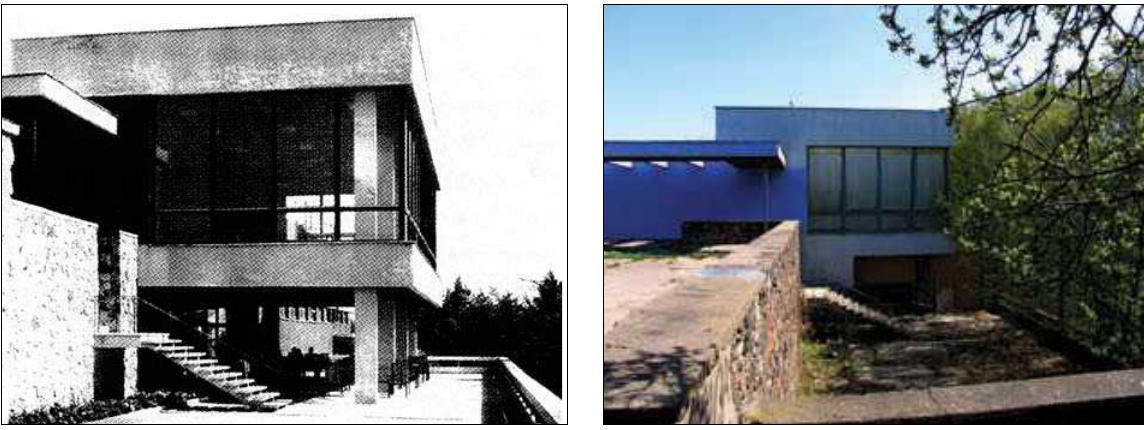
5, 6 pav. kavinė „trys mergelės“ kau­ne (arch. a­. and V. Jaku­čiūnai) 1967 m. ir dabar (5 pav. paimtas iš Lietuvos architektai/ LAS . Vilniu­s: Lietu­vos dailės akademijos leidykla, 2000; 6 pav. nu­otrau­ka au­torės) Figs. 5, 6. cafe “trys mergelės“ in kau­nas (arch. a­. and V. Jaku­čiūnai) in 1967 and 2008